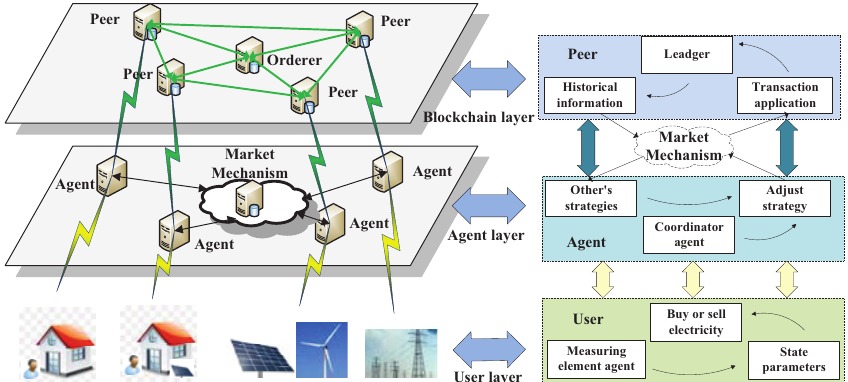
Figure 1. Hierarchical bidding and trading system based on